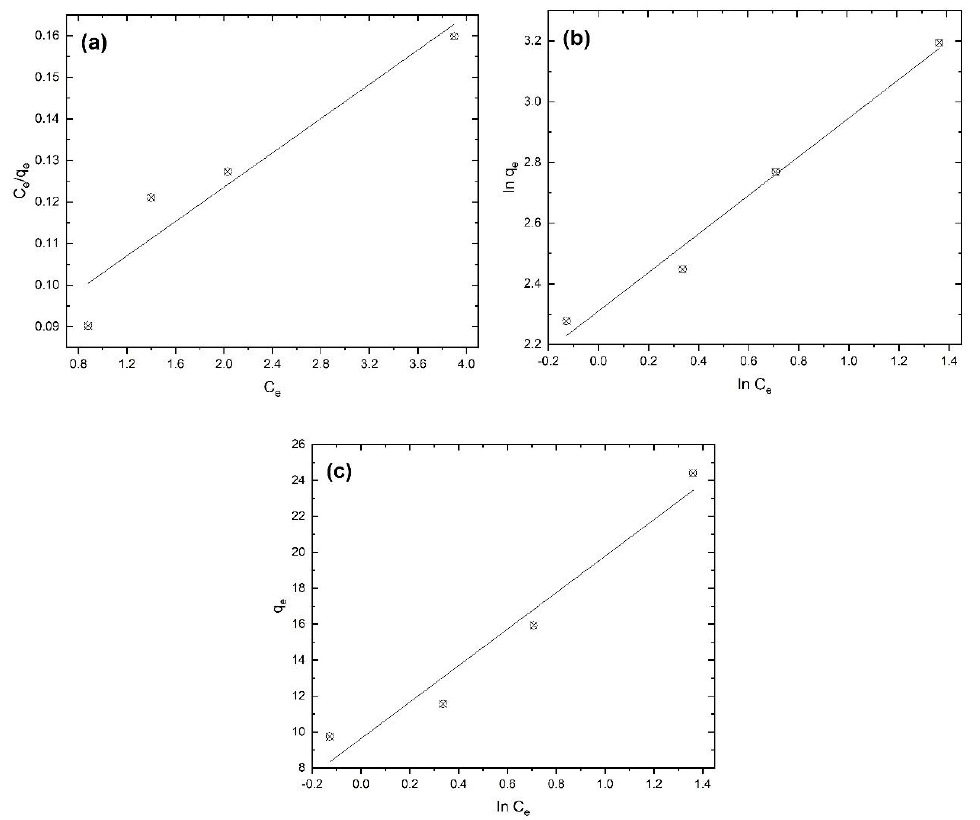
Figure 13. Linearized adsorption isotherms for ( a ) Langmuir, ( b ) Freundlich, and ( c ) Temkin at 25 °C.